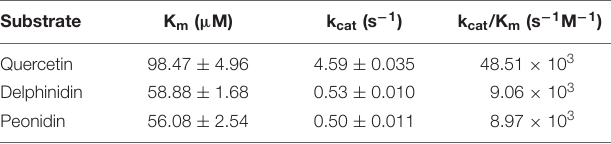
TABLE 2 | Kinetic parameters for the recombinant Fh3GT1 protein. Substrate